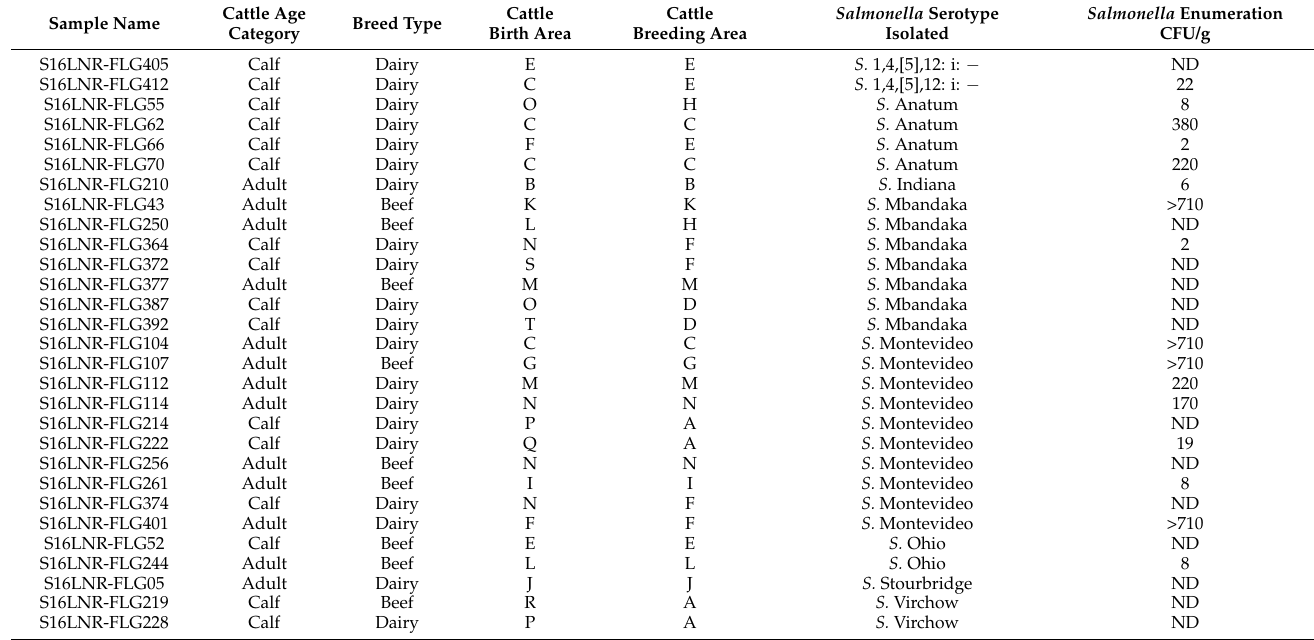
Table 2. List of the 29 Salmonella positive samples in this